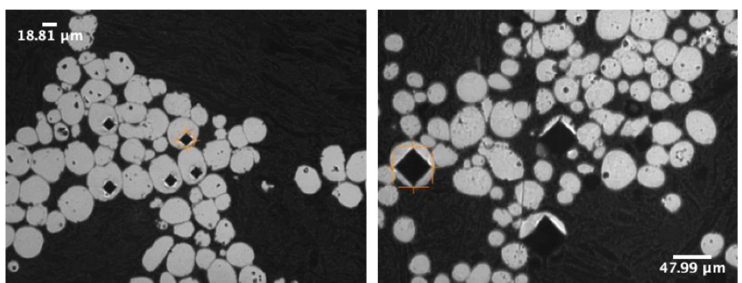
Figure 10. The ( Left ) micrograph follows from the application of 0.01 kgf during microindentation/Vickers hardness testing of an alloyed Al gas-atomized particle mounted in a phenolic resin. The micrograph on the ( Right ) demonstrates how easily the particles are overwhelmed by an applied load of 0.1 kgf. Resultantly, the composite-like interaction at the microindentation-load ranges for particle-matrix systems.